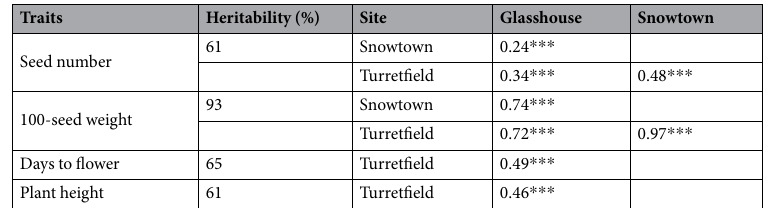
Table 2. Broad-sense heritability (H2) and pairwise correlations between glasshouse and two field sites for seed number, 100-seed weight, days to flower and plant height. Level of significance ( *** p <